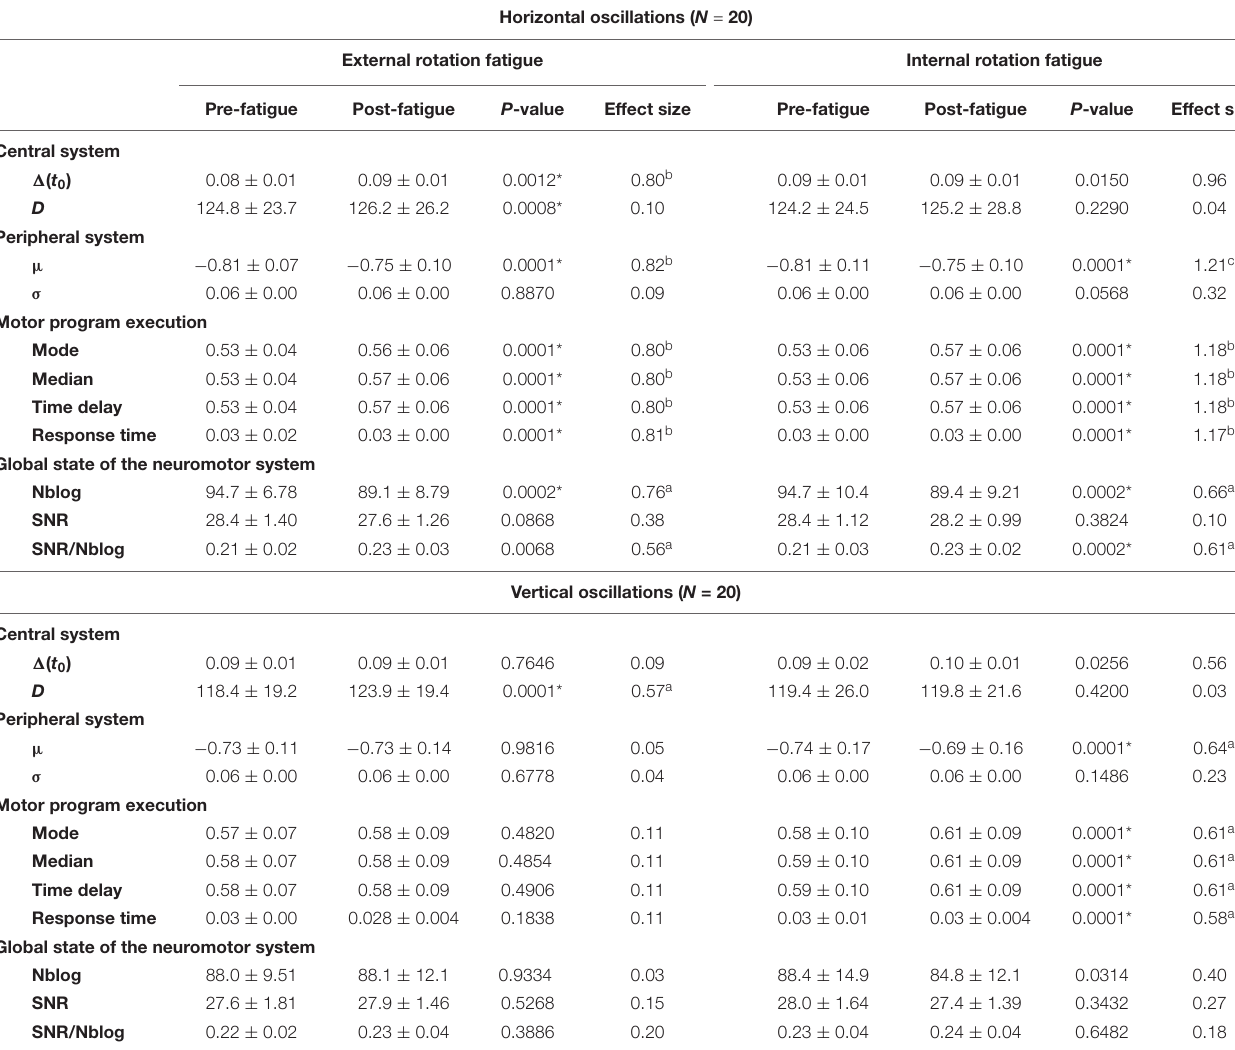
TABLE 4 | Parameters evolution in the horizontal and vertical oscillations, after a shoulder fatigue in external or internal